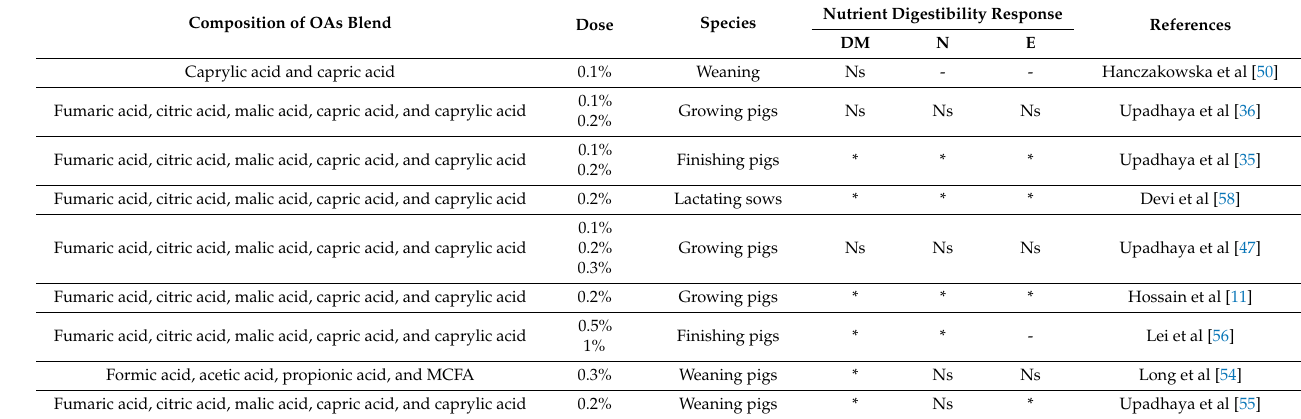
Table 3. E ff ects of OAs mixture on nutrient digestibility in pigs.